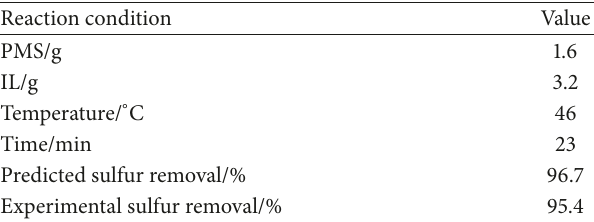
Table 4: Optimization criteria for sulfur